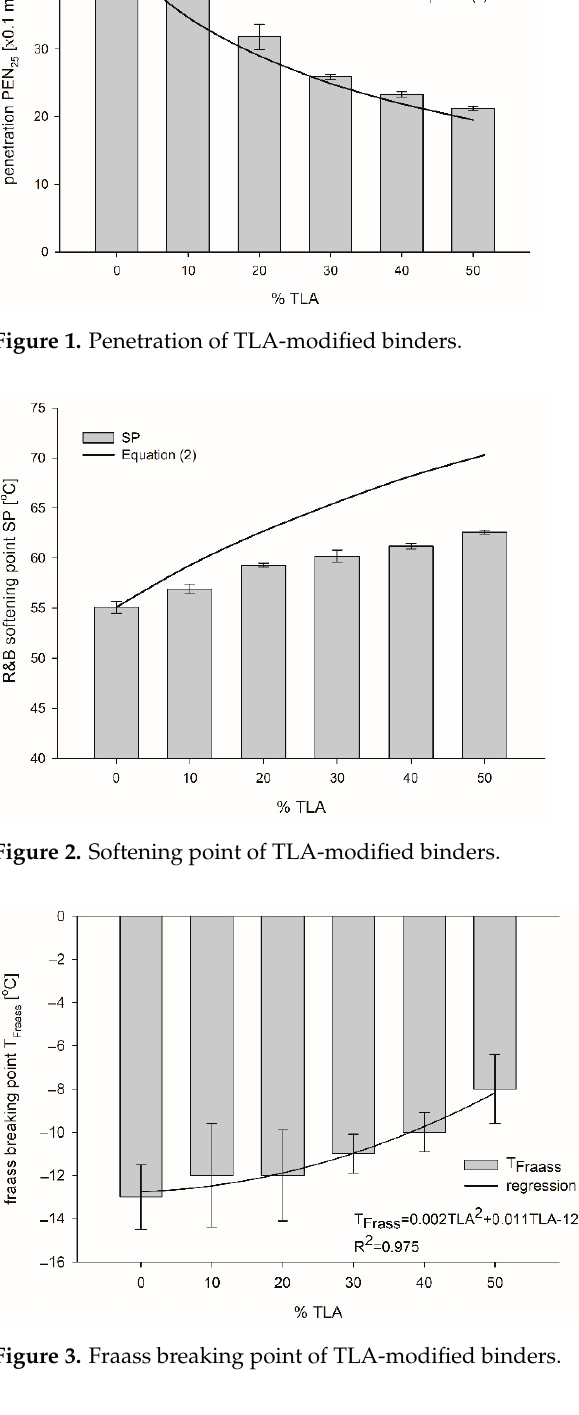
Figure 3. Fraass breaking point of TLA-modified binders.